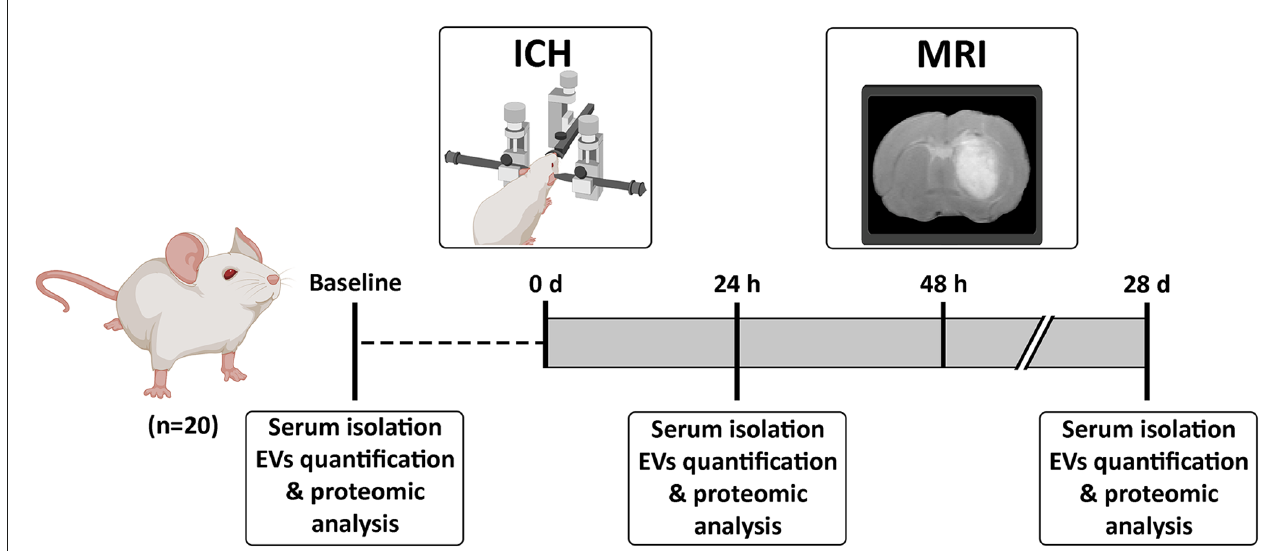
FIGURE1 Experimental procedure. Animals were subjected to an ICH and blood-derived EVs were isolated at baseline, 24 h and 28 days post-ICH. Abbreviations: EVs, extracellular vesicles; ICH, intracerebral hemorrhage; MRI, Magnetic Resonance Imaging.